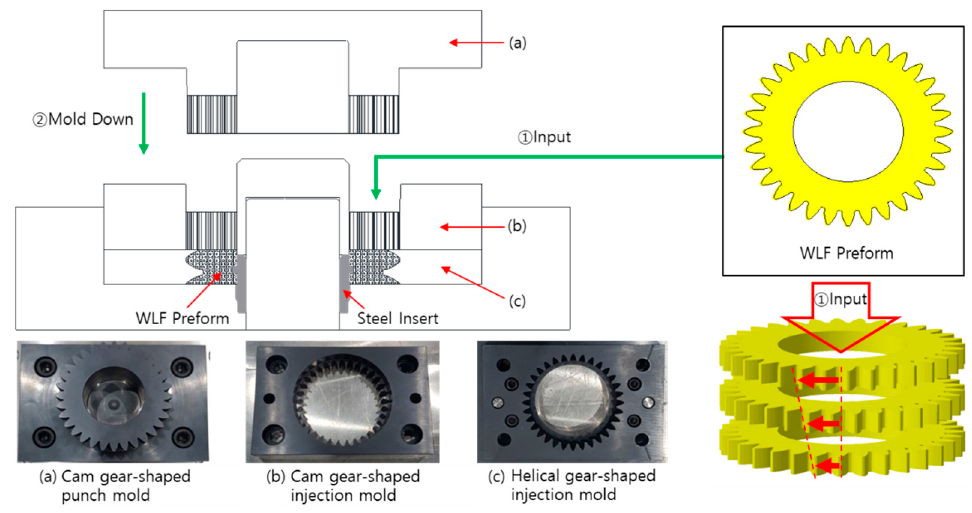
Figure 11. Input system to load the FRP material.